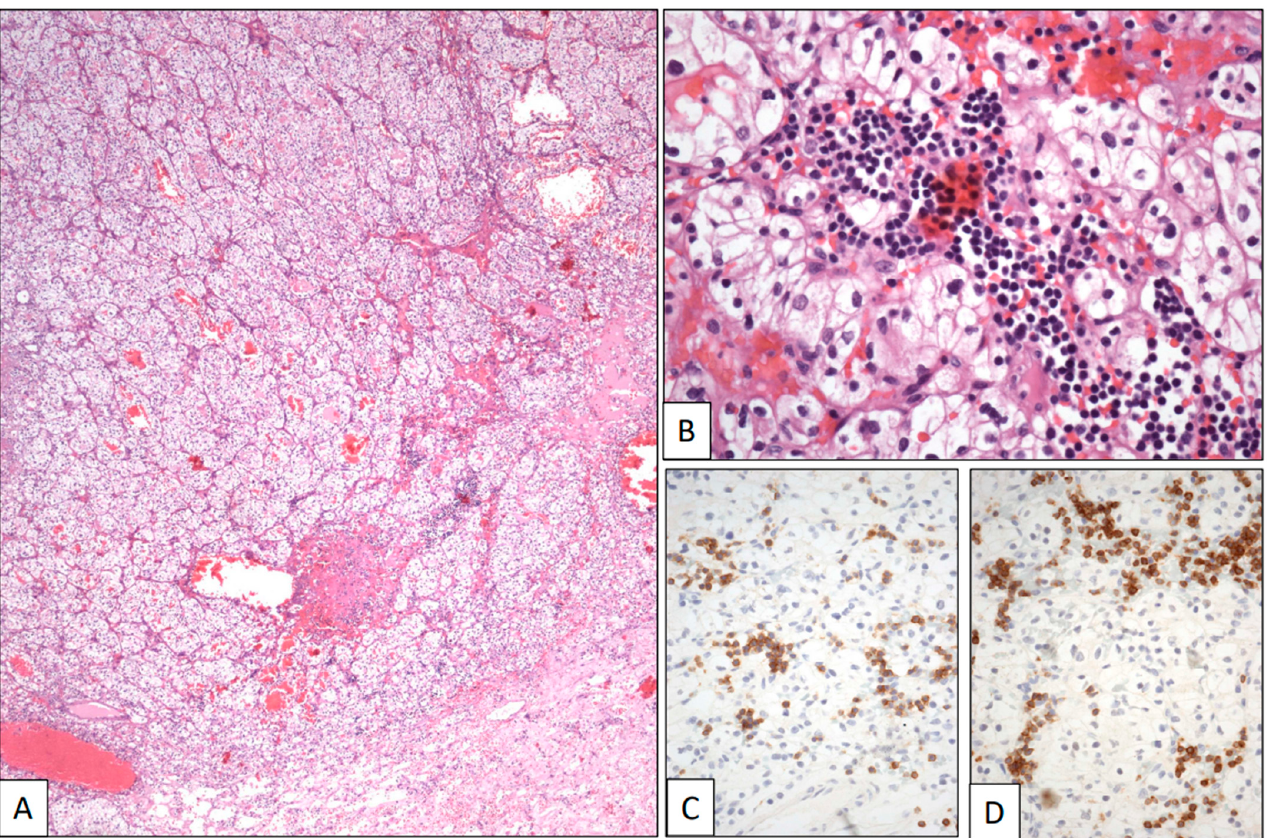
Figure 4. Clear cell renal cell carcinoma infiltrated by chronic lymphocytic leukemia. ( A ) Panoramic view of a conventional low-grade clear cell renal cell carcinoma. ( B ) Histological detail showing neoplastic clear cells intermingled with a small-celled monotonous lymphocytic infiltration showing positive immunostaining with CD5 ( C ) and CD79 α ( D ).